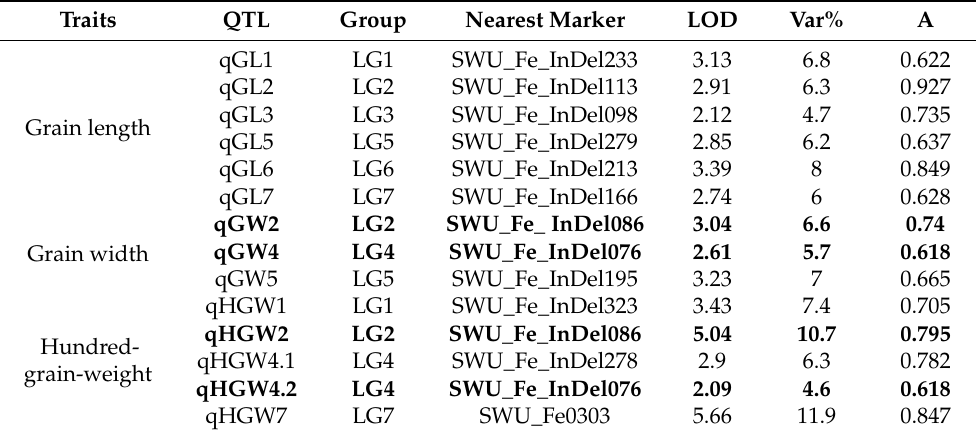
Table 4. QTL controlling grain size traits identified from the F 1